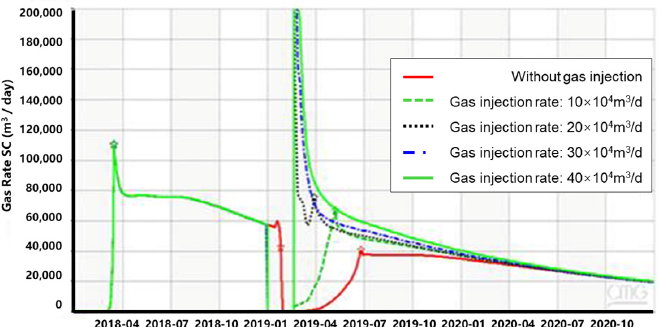
Figure 19. Effect of injection rate of pressurization on gas rate.